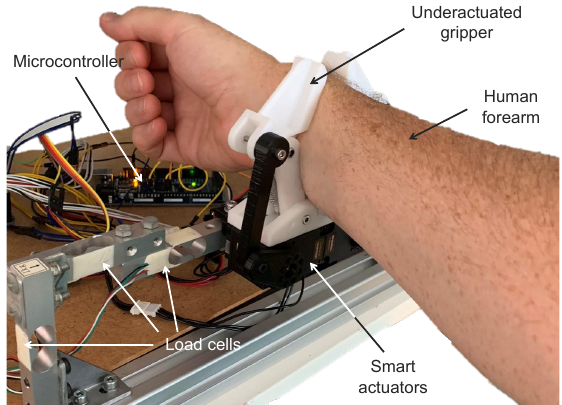
Figure 4. Illustration of the data collection process with the experimental force-sensing system (left side visible only) to record ground-truth data and gripper readings to train the regression methods. Please note that only three load cells (left finger) are visible in this picture as the other three (right finger) are hidden by the human forearm.